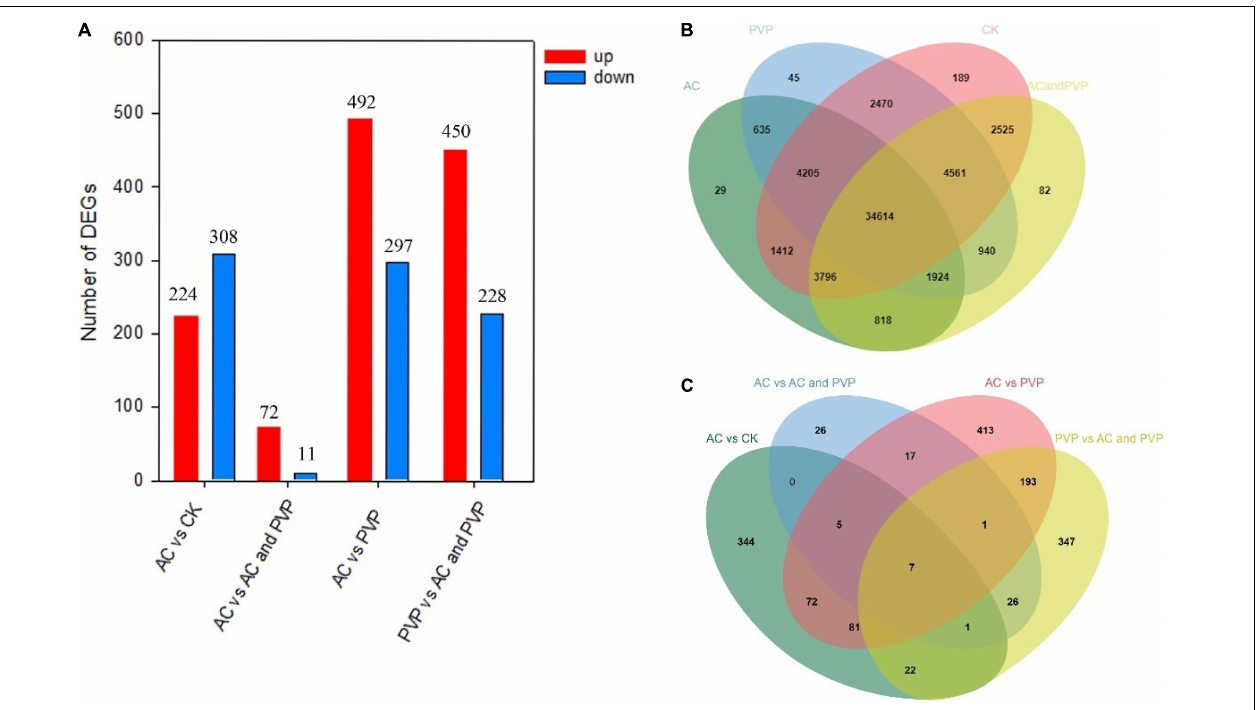
FIGURE 4 | (A) The histograms of DEGs between samples; (B) Venn diagrams for transcriptome analysis of the expressed genes detected in the four groups; (C) Venn diagrams for transcriptome analysis of the DEGs detected between different